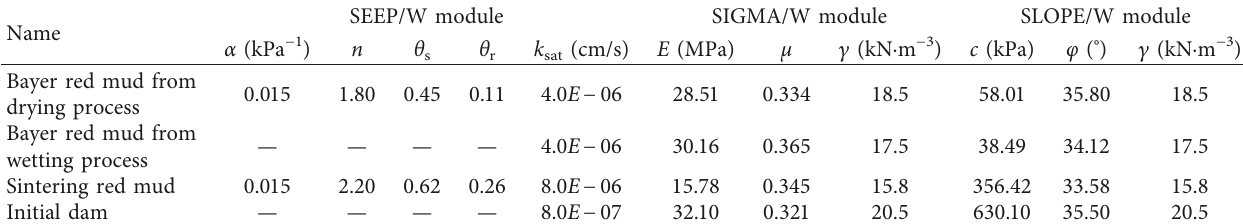
Table 6: The related parameters used in the three modules of SEEP/W, SIGMA/W, and SLOPE/W. SEEP/W module SIGMA/W module SLOPE/W Name